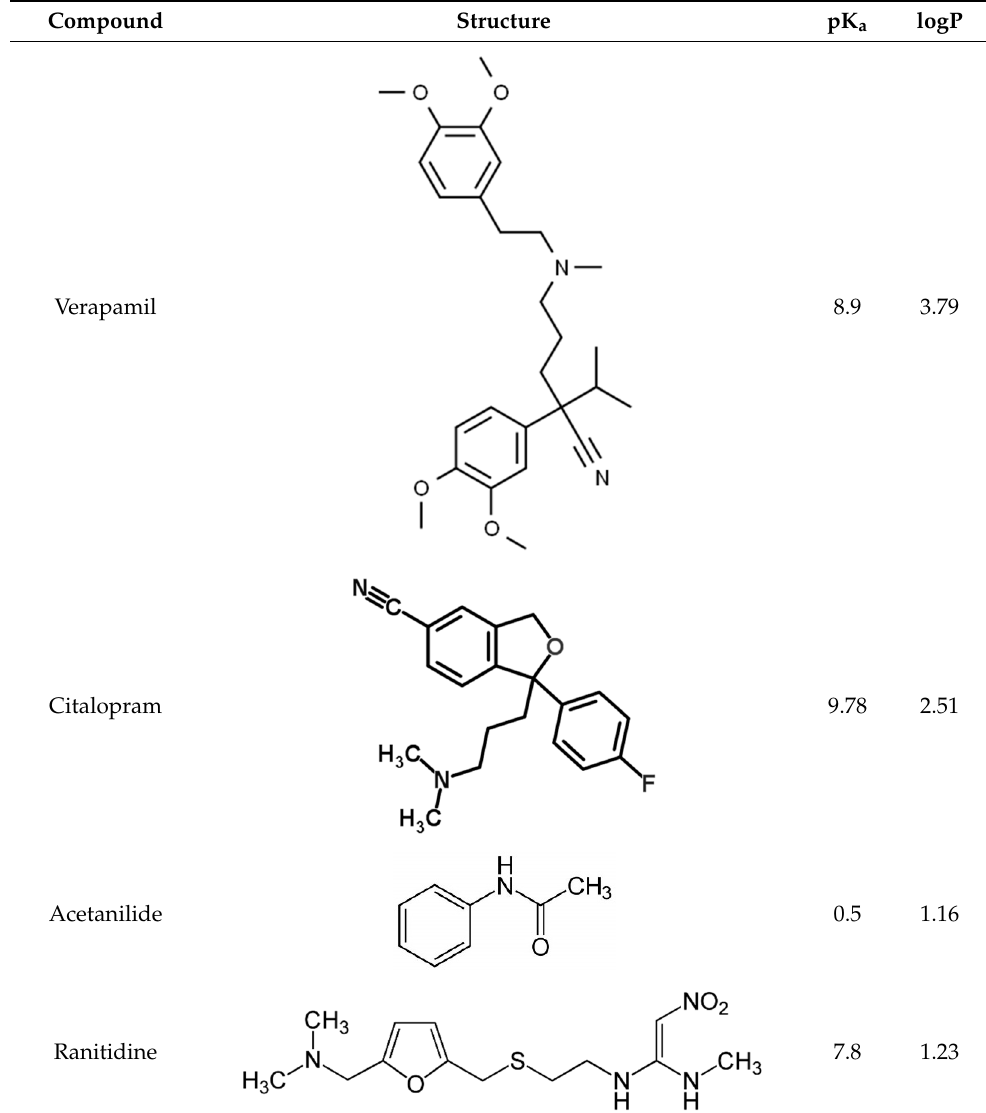
Table 1. Structure, acidity constant of conjugated acid (pK a ), and logarithm of the partition coefficient in the n-octanol/water system (logP) of compounds studied.